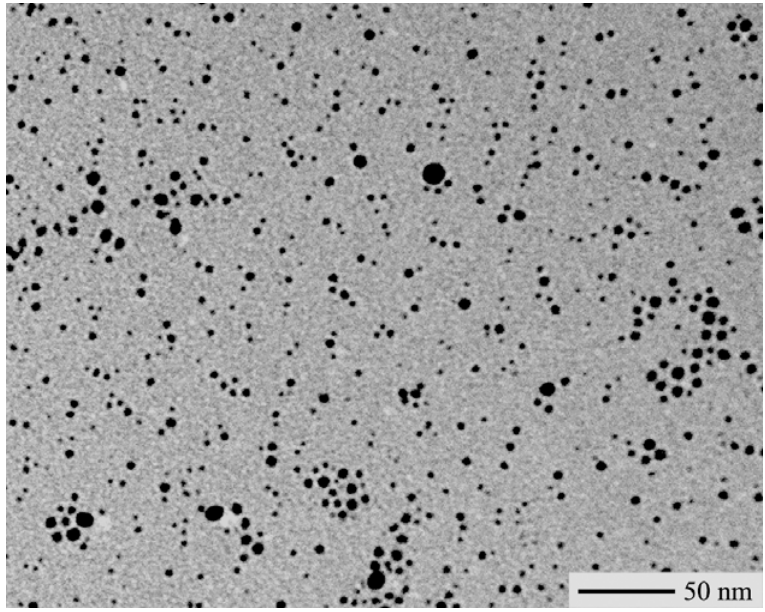
Figure 4. TEM-micrograph of a silver-polystyrene nanocomposite sample obtained by annealing a AgSC H /polystyrene 12 25